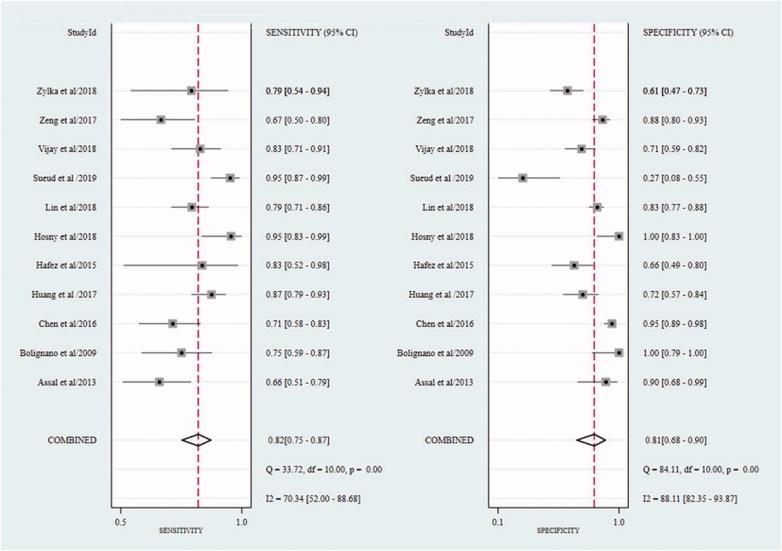
The forest plot of sensitivity and specificity of cross-sectional studies.